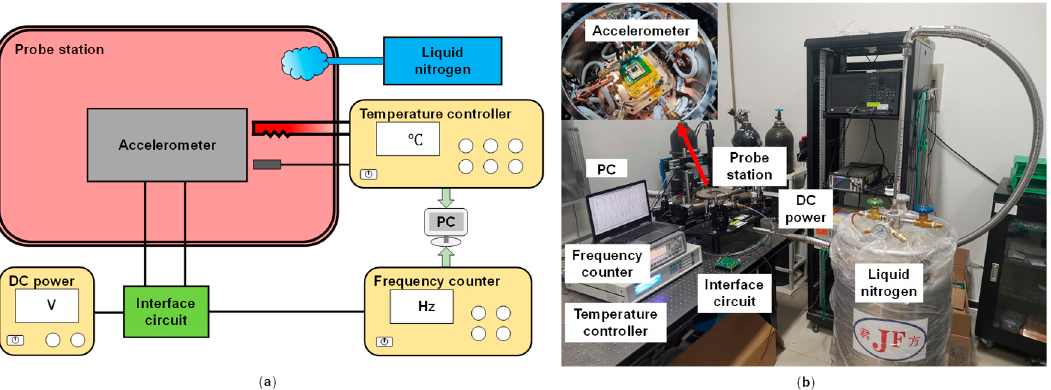
Figure 4. Temperature experiment setup. ( a ) The schematic of the temperature experiment: The probe station act as a temperature oven heated up by the temperature controller and cooled down by liquid nitrogen. The accelerometer was zero-bias and driven by an interface circuit. The frequency counter monitored the frequency changes. ( b ) The real picture of the temperature experiment.